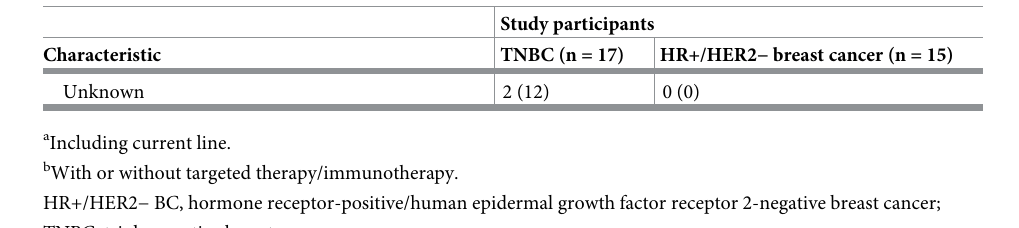
Table 2. Salient symptoms a and impacts reported by patients with TNBC and HR+/HER2 − breast cancer. n (%) TNBC HR+/HER2 − breast cancer Total Average bother rating